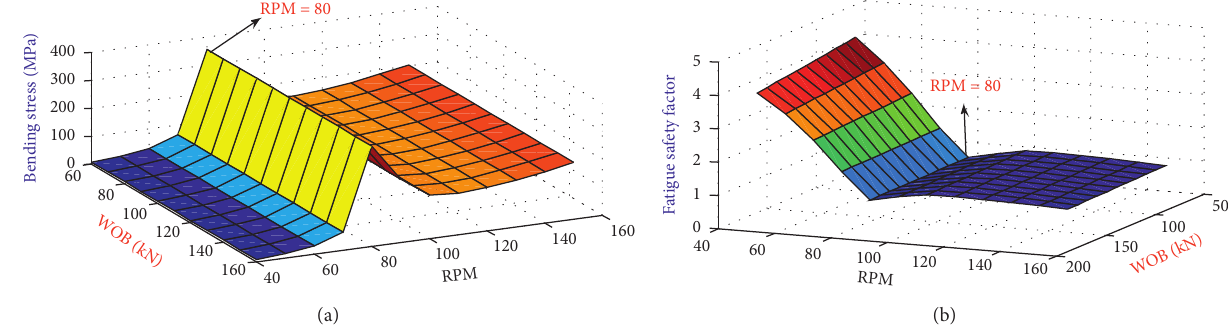
Figure 13: (a) Diagram of bending stress of point A . (b) Diagram of fatigue safety factor of point A .